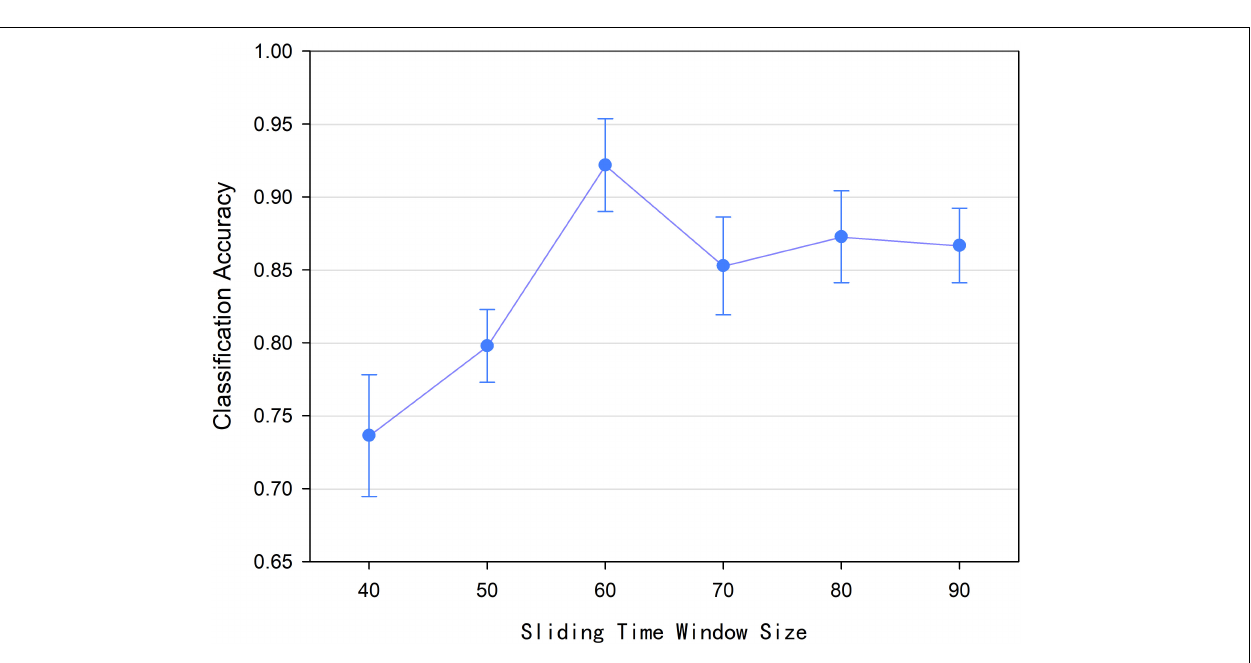
FIGURE 8 | Classification accuracy of different sliding time window